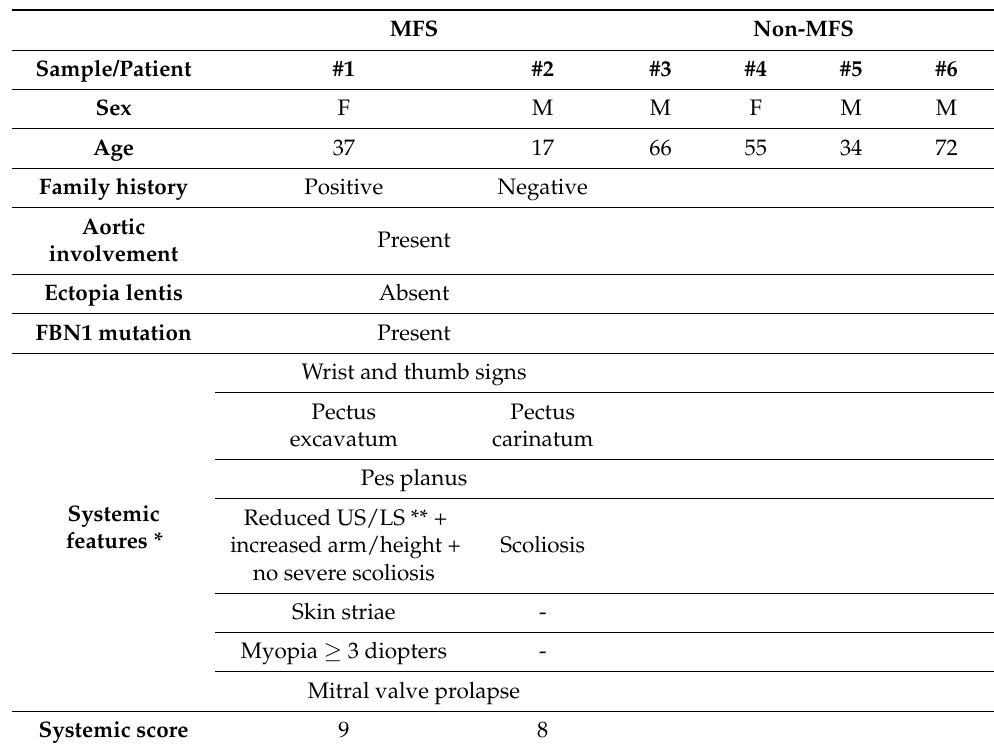
Table 1. Summary of the two studied populations and diagnostic characteristics of the MFS